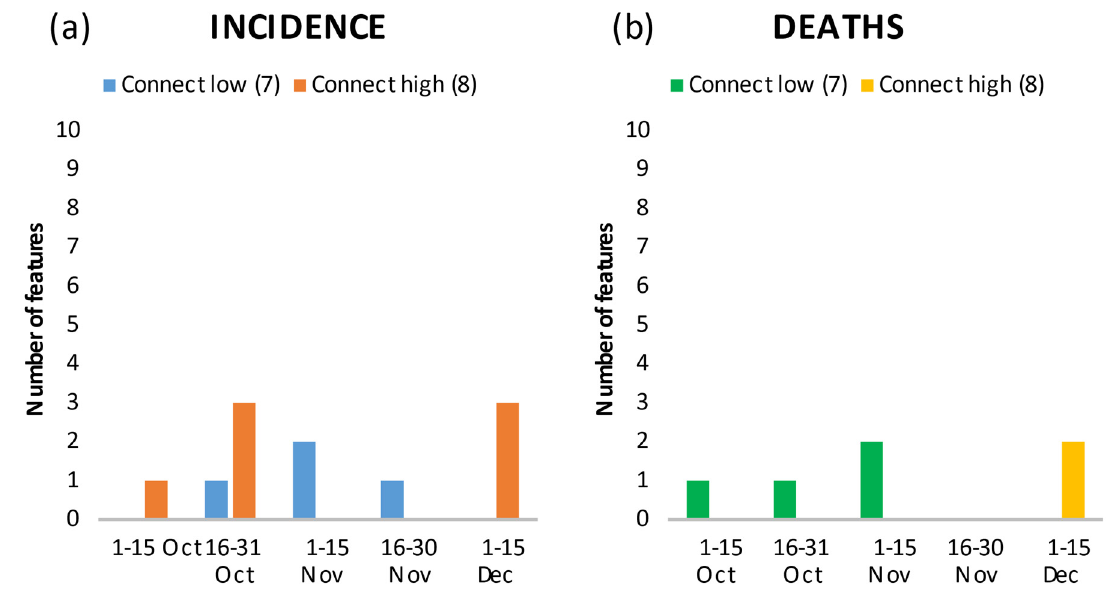
Figure 5. Number of features in the top 20 showing the relationship between connectedness, and incidence ( a ) and death rates ( b ) by time period.